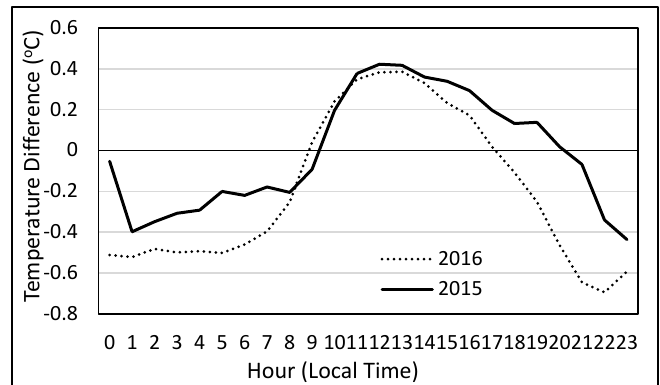
Figure 7. Temperature difference (calculated as the difference between values from two air temperature sensors at different heights—the lower sensor minus the higher sensor) and used as the indicator for flux direction.